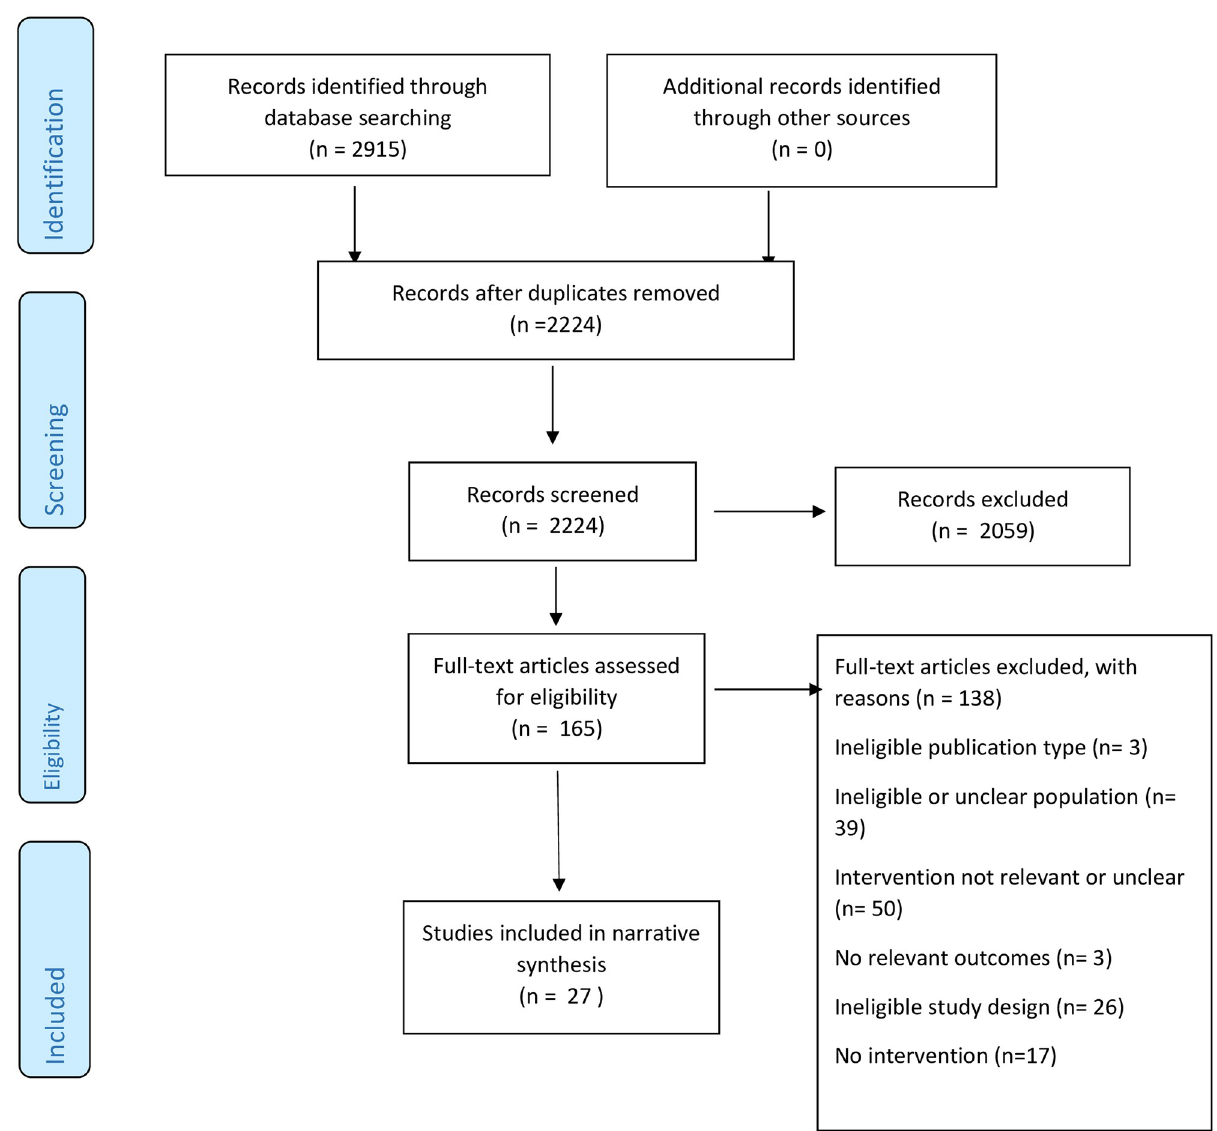
Fig 1. Flow chart summarizing identification of studies for inclusion in this systematic review using PRISMA [25].